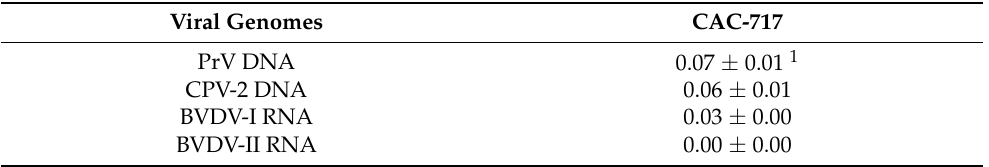
Table 6. Direct application of CAC-717 to genomes of the viruses whose DNA or RNA was